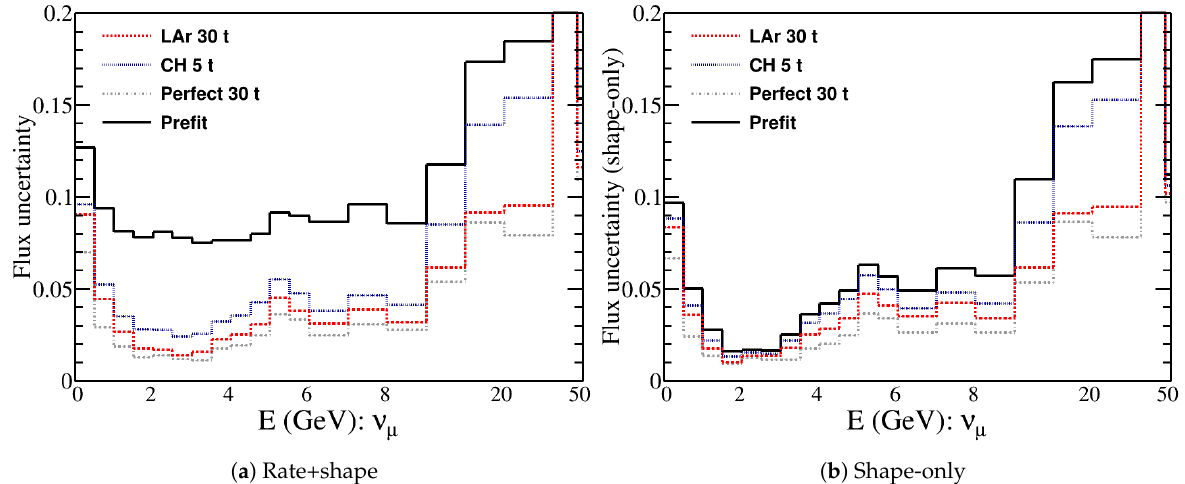
Figure 40. Rate+shape and shape-only bin-by-bin flux uncertainties as a function of neutrino energy for a five year exposure of the baseline 1.2MW beam, with various detector options, compared with the input flux covariance matrix before